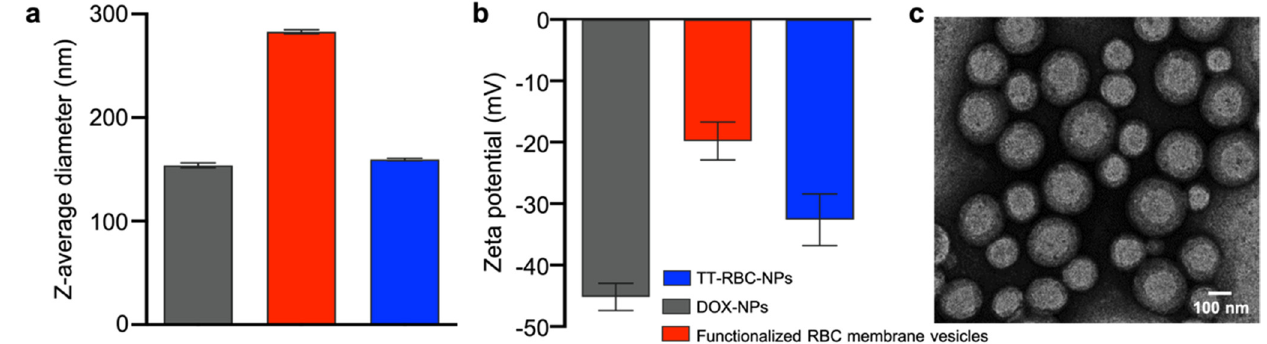
Figure 2. Physicochemical characterization of TT-RBC-NPs. ( a ) Hydrodynamic size and ( b ) zeta potential of non-coated doxorubicin-loaded nanoparticles (DOX NPs), RBC membrane vesicles, and TT-RBC NPs (mean ± SD, n = 3). ( c ) Transmission electron micrographs of TT-RBC-NPs. Scale bar = 100 nm.